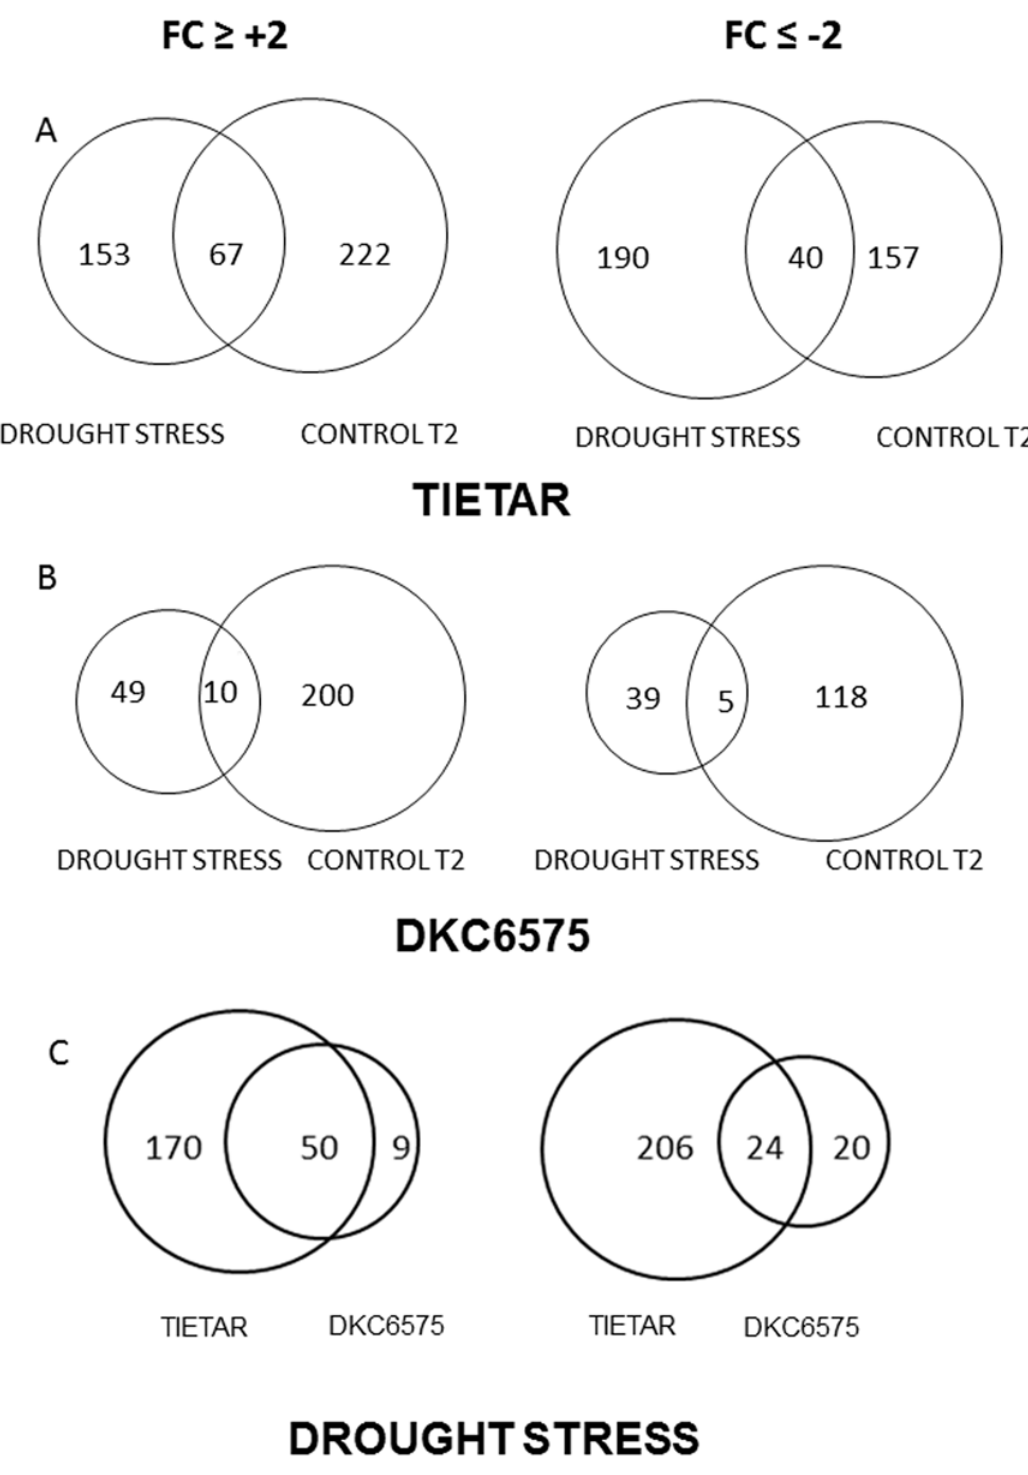
Fig 7. Venn diagrams representing the number of genes differentially expressed based on microarray analysis. Plants grown in the Field experiment were sampled at the developmental stage T2 in the drought stress condition and at T1 and T2 in the control condition. Genes considered are those showing a fold change (FC) (cid:2) ±